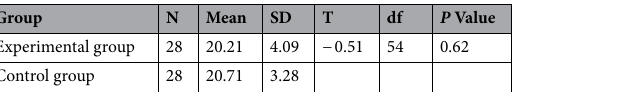
Table 1. T-test of students’ pre-test results.